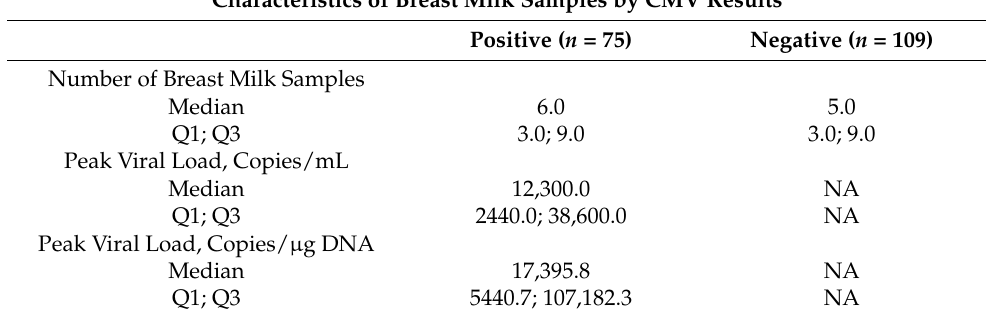
Table 2. Characteristics of breast milk samples by CMV PCR results. Data shown are for 184 infants born to 150 mothers (for whom breast milk was available for PCR testing). In total, 75 infants were exposed to CMV-PCR-positive milk (41%) and 109 received PCR-negative milk (59%). Characteristics of Breast Milk Samples by CMV